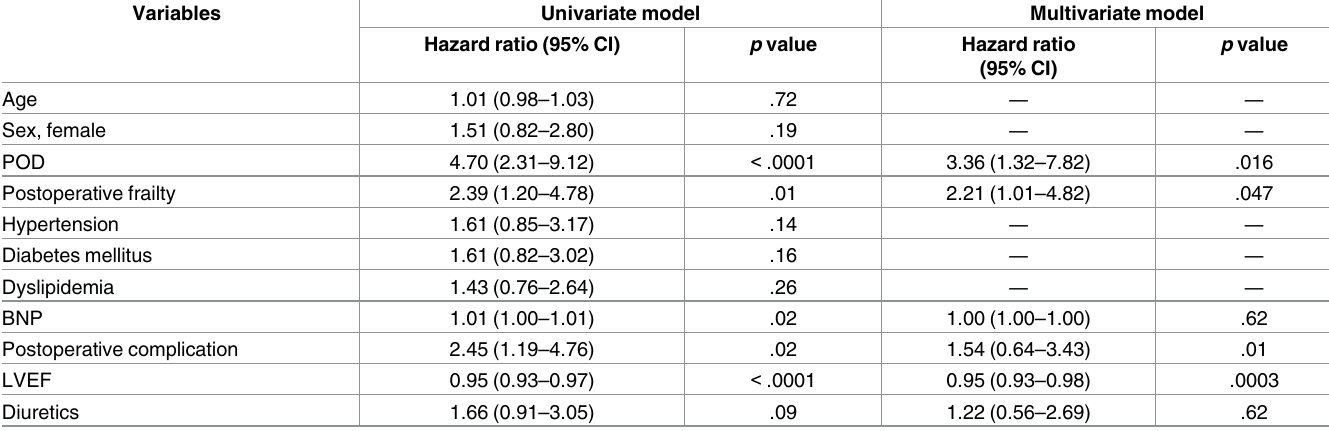
Table 5. Independent predictors of MACE for patients undergoing cardiac surgery (Cox-hazard analysis).